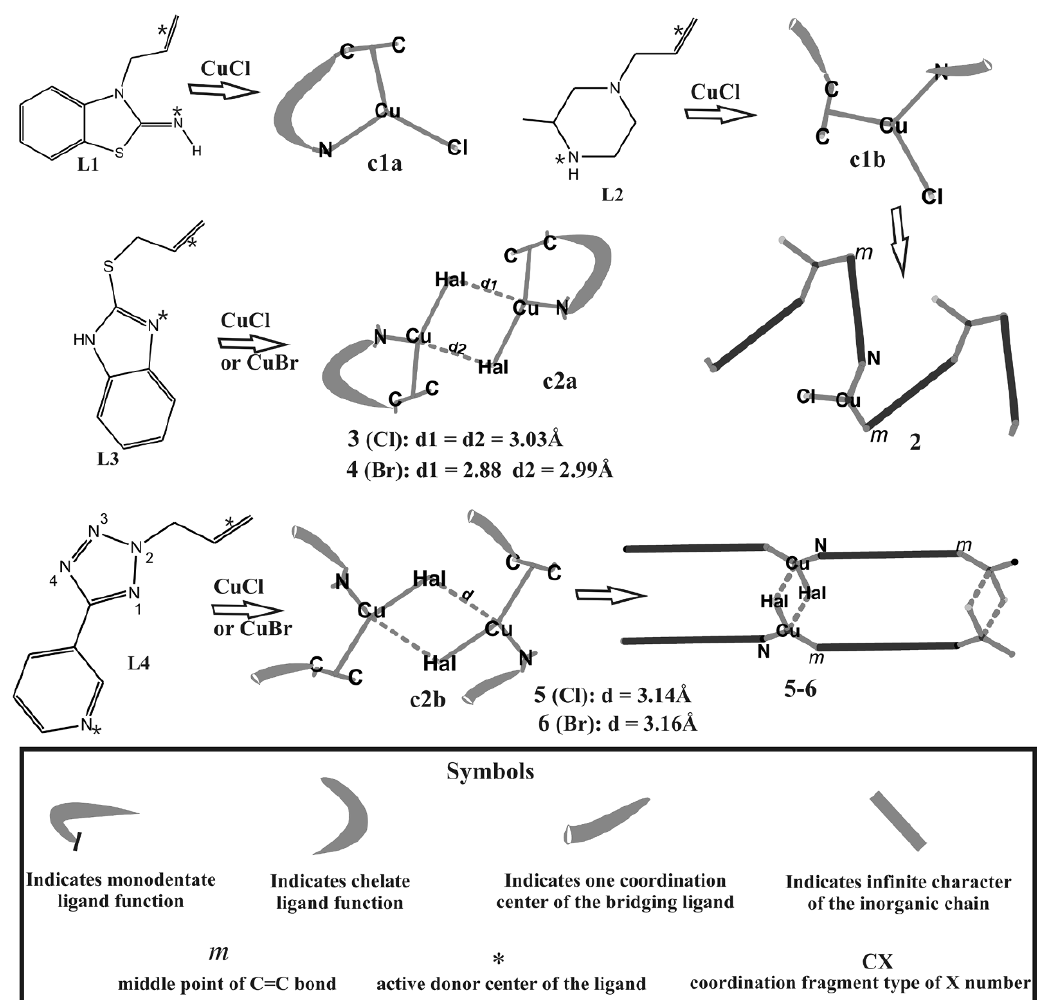
Figure 2. Structural genesis of C1 and C2 fragments in 1-6